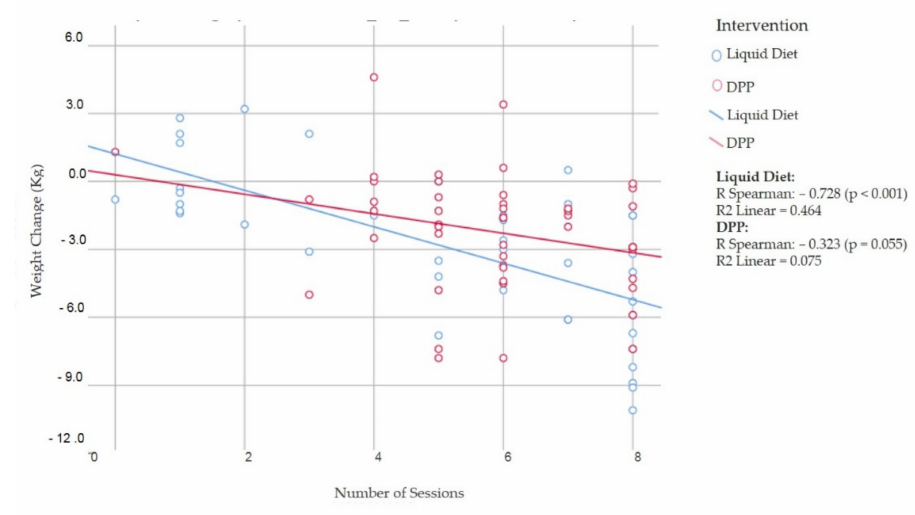
Figure 3. Correlation between weight change and the number of sessions attended.